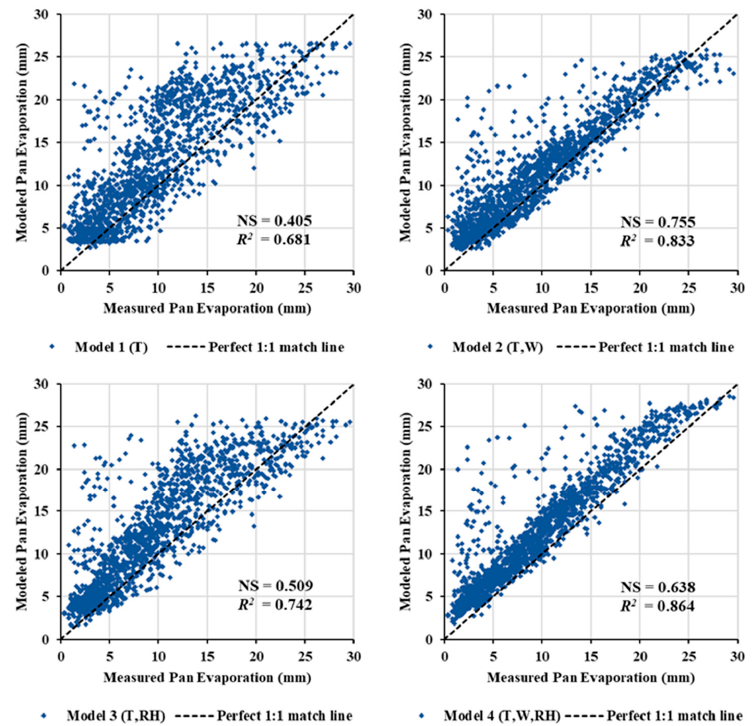
Figure 6. Modeled versus measured pan evaporation depths (mm) for the validation period at KIA weather station. T: average daily temperature; RH: average relative humidity; W: average wind speed.